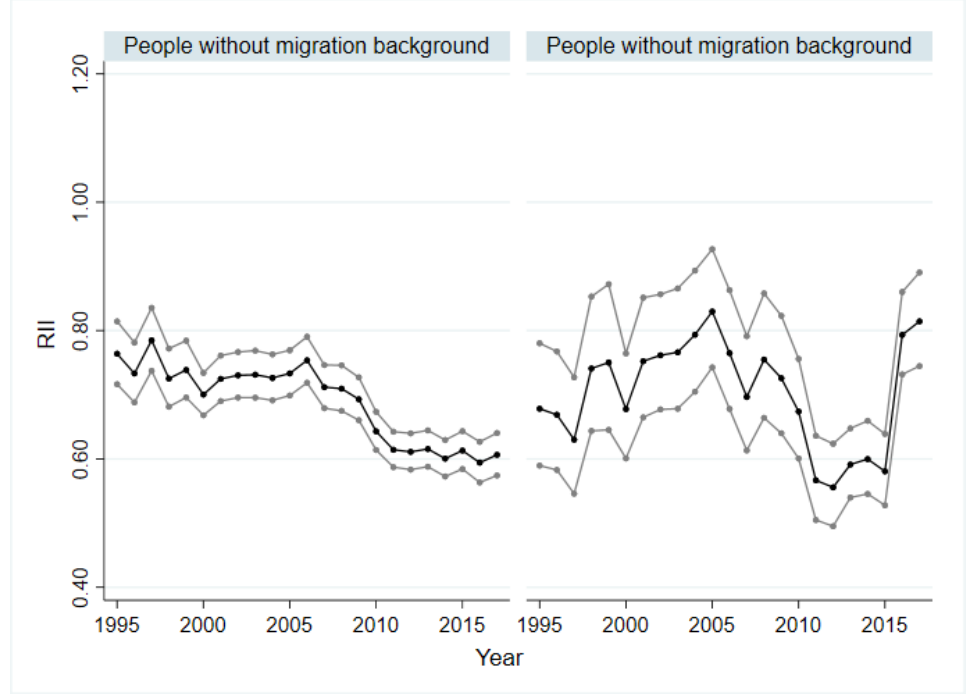
Figure 2. Relative socio-economic inequalities in SRH in people with and without migration background, 1995–2017. SRH: self-rated health; RII: relative index of inequality; black line: regression coefficient; grey line: 95% confidence interval.